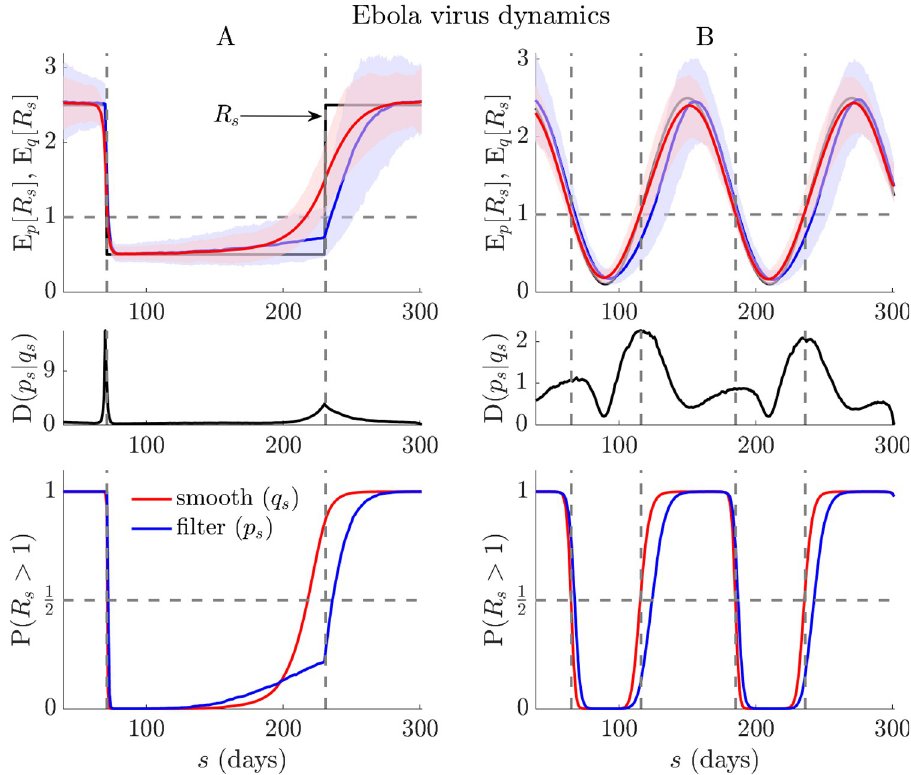
Fig 2. Resurgence and control dynamics of Ebola virus. Using renewal models with the generation time from [46], we simulate 1000 realisations of Ebola virus epidemics ( t = 300) with step (A panels) and seasonally (B panels) changing transmissibility (true R in black). Top panels show posterior mean estimates from the filtered (E s and smoothed (E q [ R s ], red) distributions from every realisation (computed using EpiFilter [15]). Middle panels average the Kullback-Liebler divergences from those simulations, D ( p | q ), and bottom panels display the overall filtered s s ( P ð R > 1 j I s Þ , blue), and smoothed ( P ð R > 1 j I t Þ , red) probabilities of resurgence. We find fundamental and striking 1 1 s s delays in detecting resurgence, often an order of magnitude longer than those for detecting control or suppression